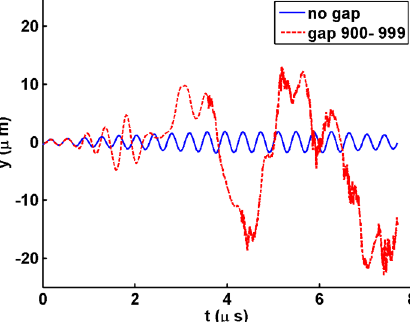
FIG. 18. Oscillation of an ion cloud ( y -component) interacting with a full bunch train and a bunch train with 100 gaps between each 900th and 999th position of the train.